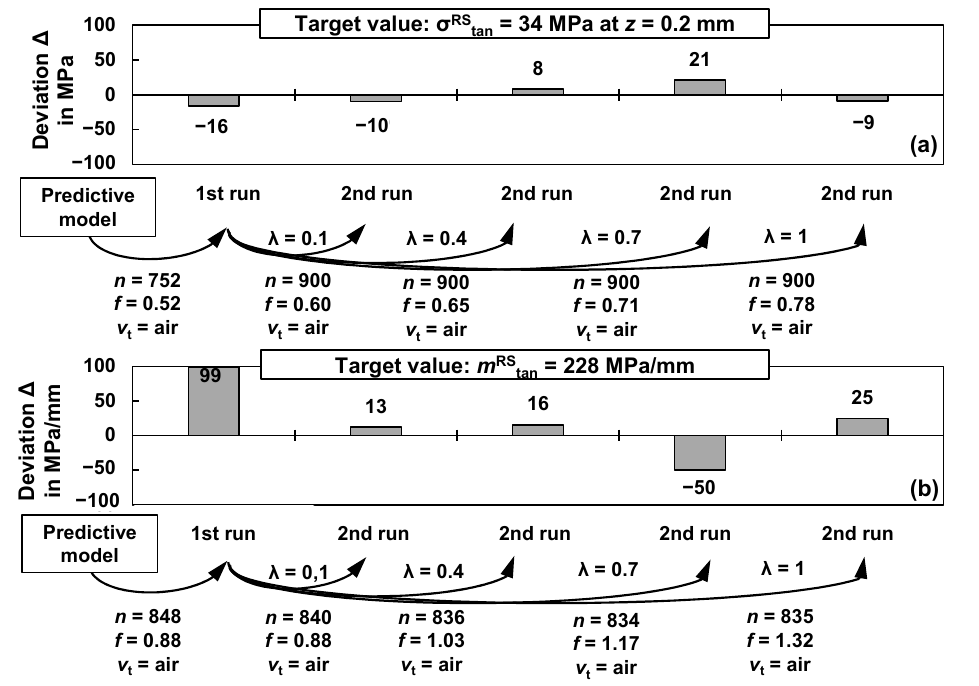
Figure 13. Performance of the run-to-run predictive control for two runs with two target values using the damping factors λ = 0.1, 0.4, 0.7 and 1 for the feedback. Flange forming by friction spinning of steel tubes (1.0308). ( a ) Target value σ RS tan = 34 MPa at z = 0.2 mm, ( b ) target value m RS tan = 228 MPa/mm.